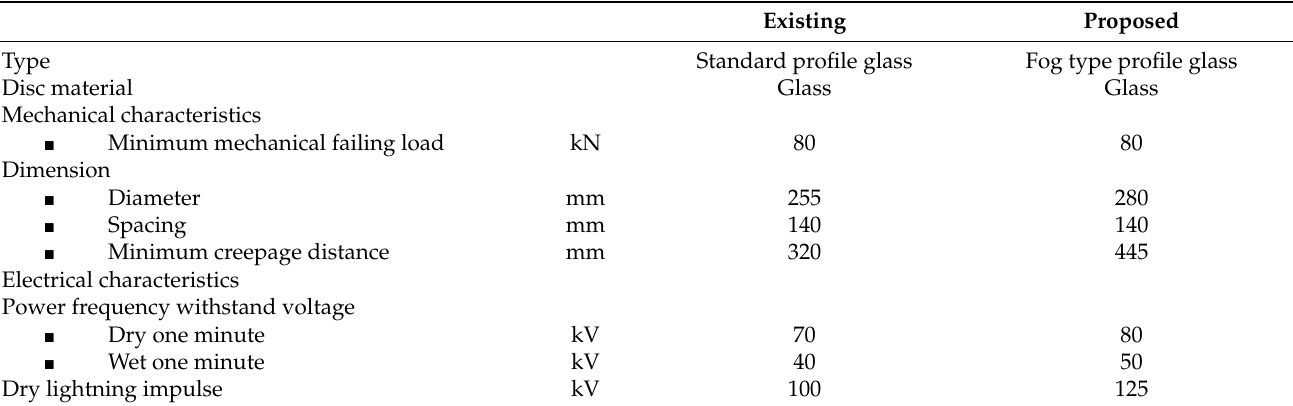
Table 4. Proposed suspension string insulator.